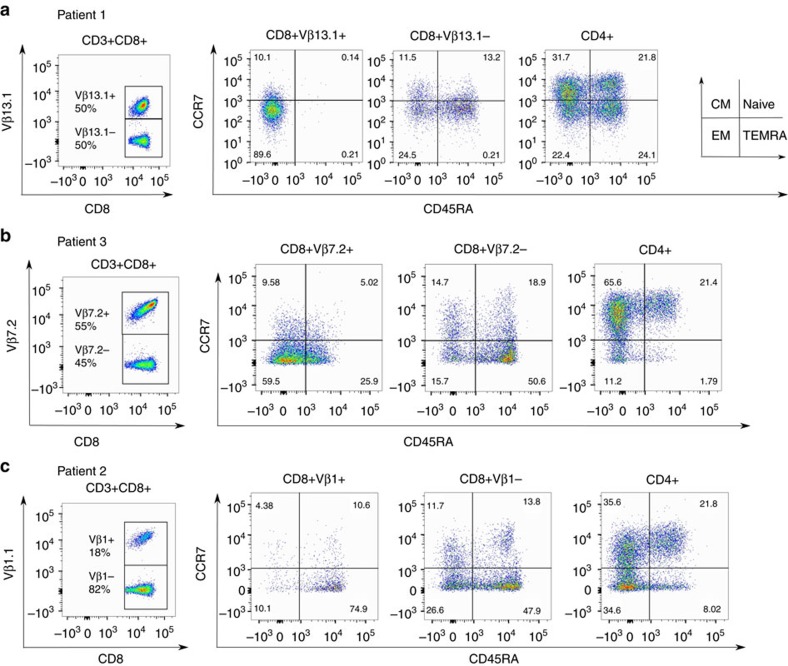
Expanded CD8+ T-cell clones are effector-memory T cells.Multicolour-flow cytometry was used to determine the phenotype of patients’ T cells in samples taken during the follow-up. CCR7 and CD45RA were used to determine whether the cells were central memory (CM), naive, effector-memory (EM) or terminal effector-memory RA-positive (TEMRA) cells. (a) The CD8+ Vβ13.1+ cells of patient 1 comprise 50% of all CD8+ T cells. The phenotype of CD8+Vβ13.1+, other CD8+, and CD4+ T cells are displayed in separate plots. (b) The phenotype of CD8+Vβ7.2+, other CD8+, and CD4+ T cells of patient 3 are displayed in separate plots. (c) The phenotype of expanded CD8+Vβ1+, other CD8+, and CD4+ T cells of patient 2 are presented in separate plots.